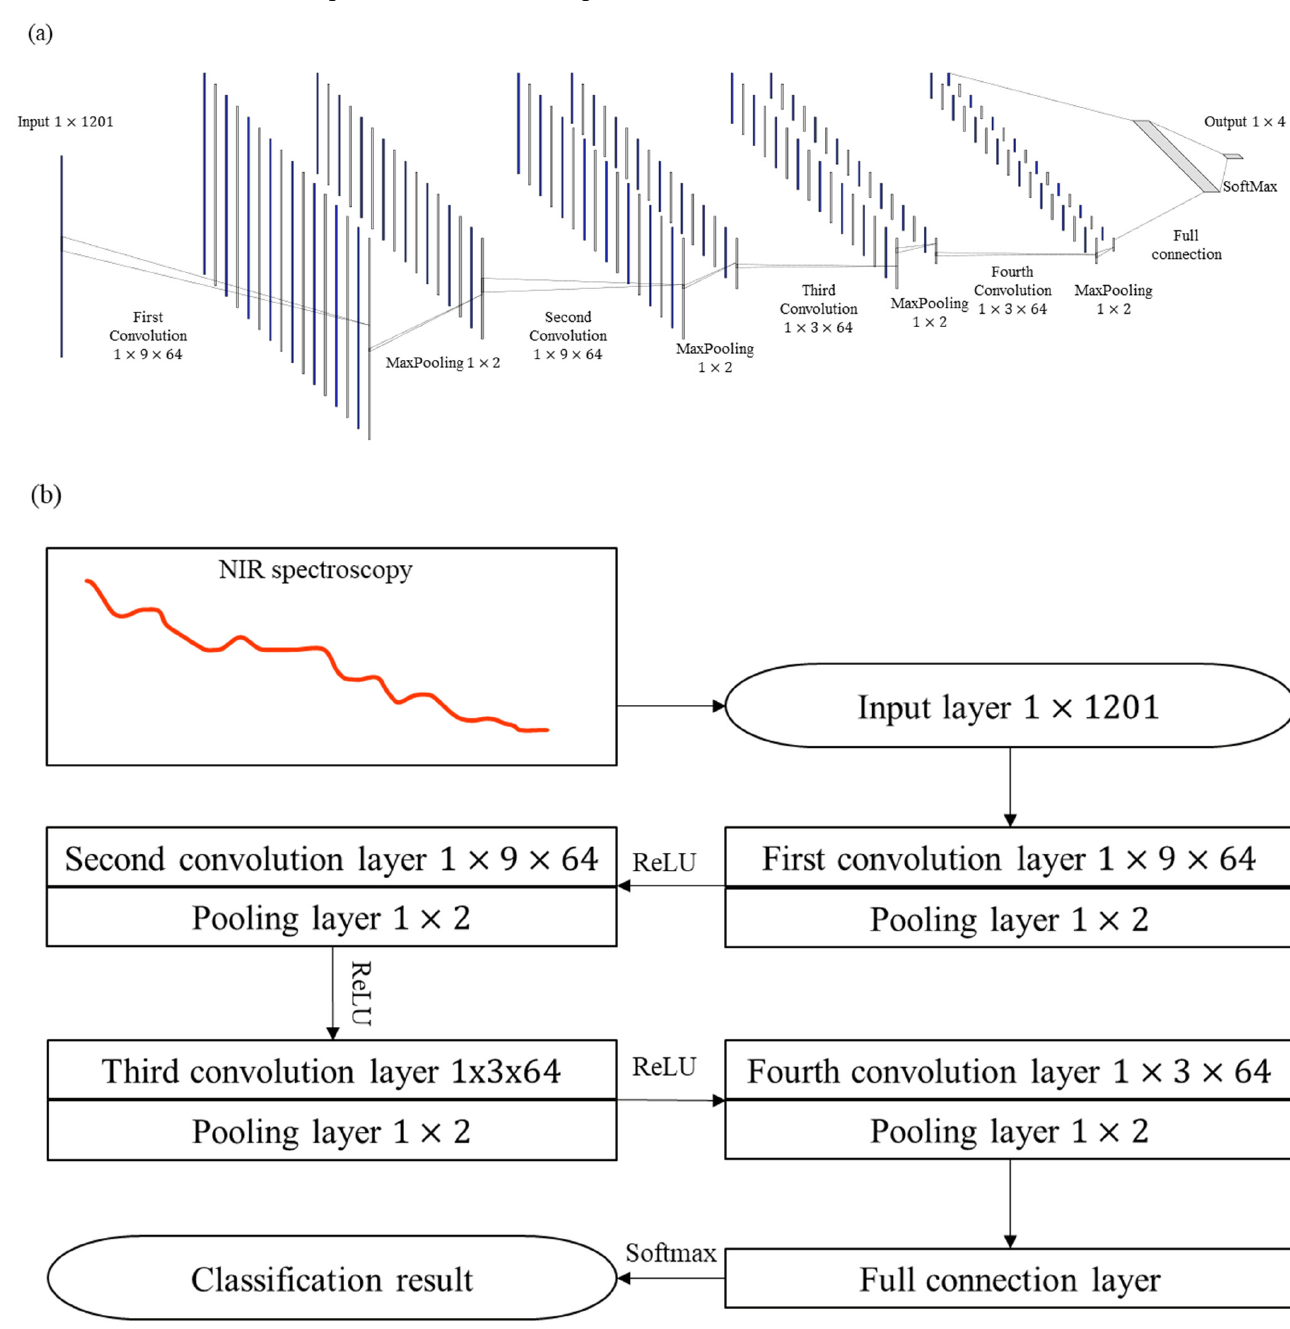
Figure 2. A schematic diagram of the proposed 1D-CNN classification model: ( a ) basic structure; ( b ) architectural details.